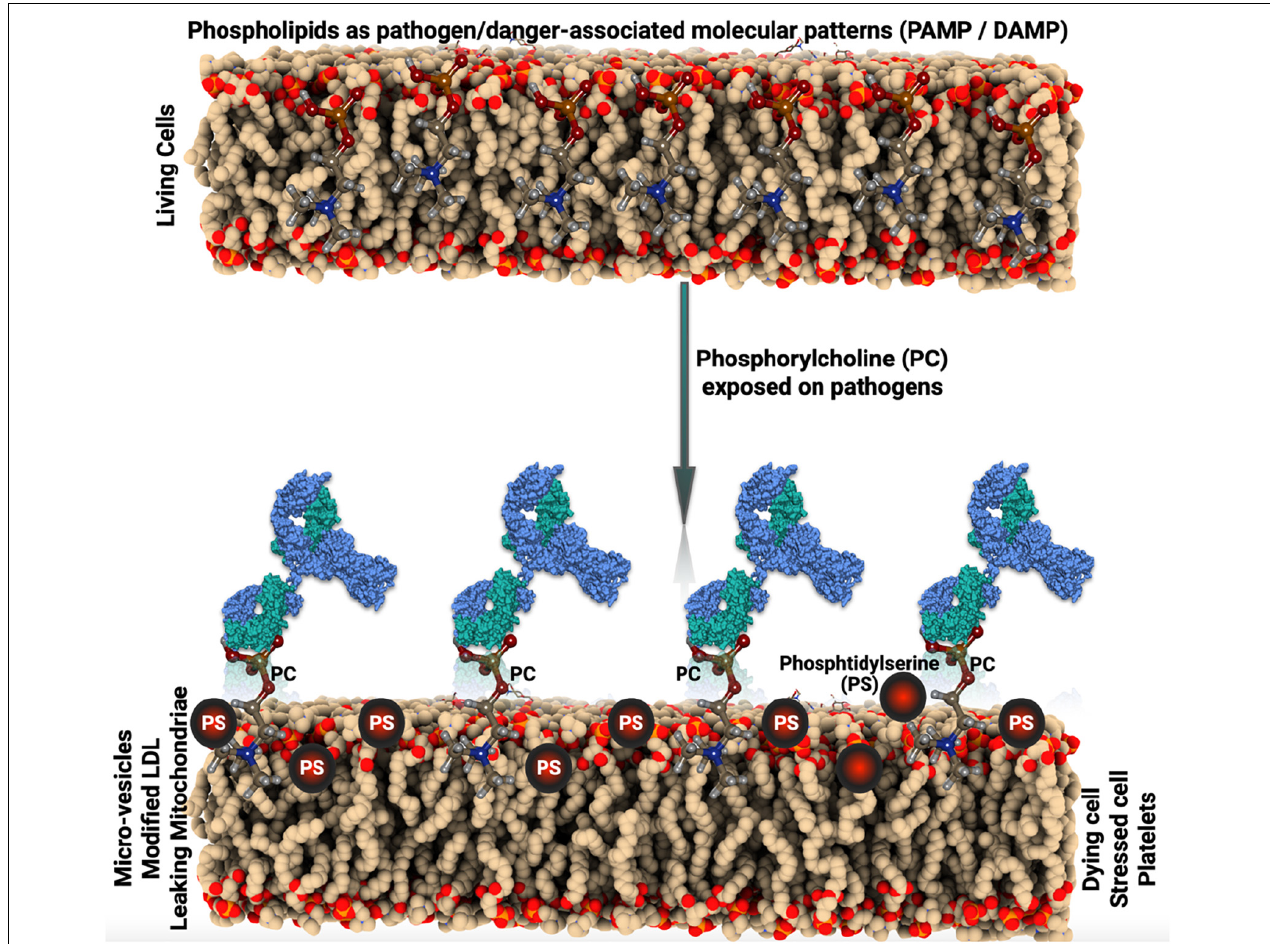
FIGURE 1 | Schematic illustration of the pathogen-associated molecular pattern (PAMP) and danger-associated molecular pattern (DAMP)